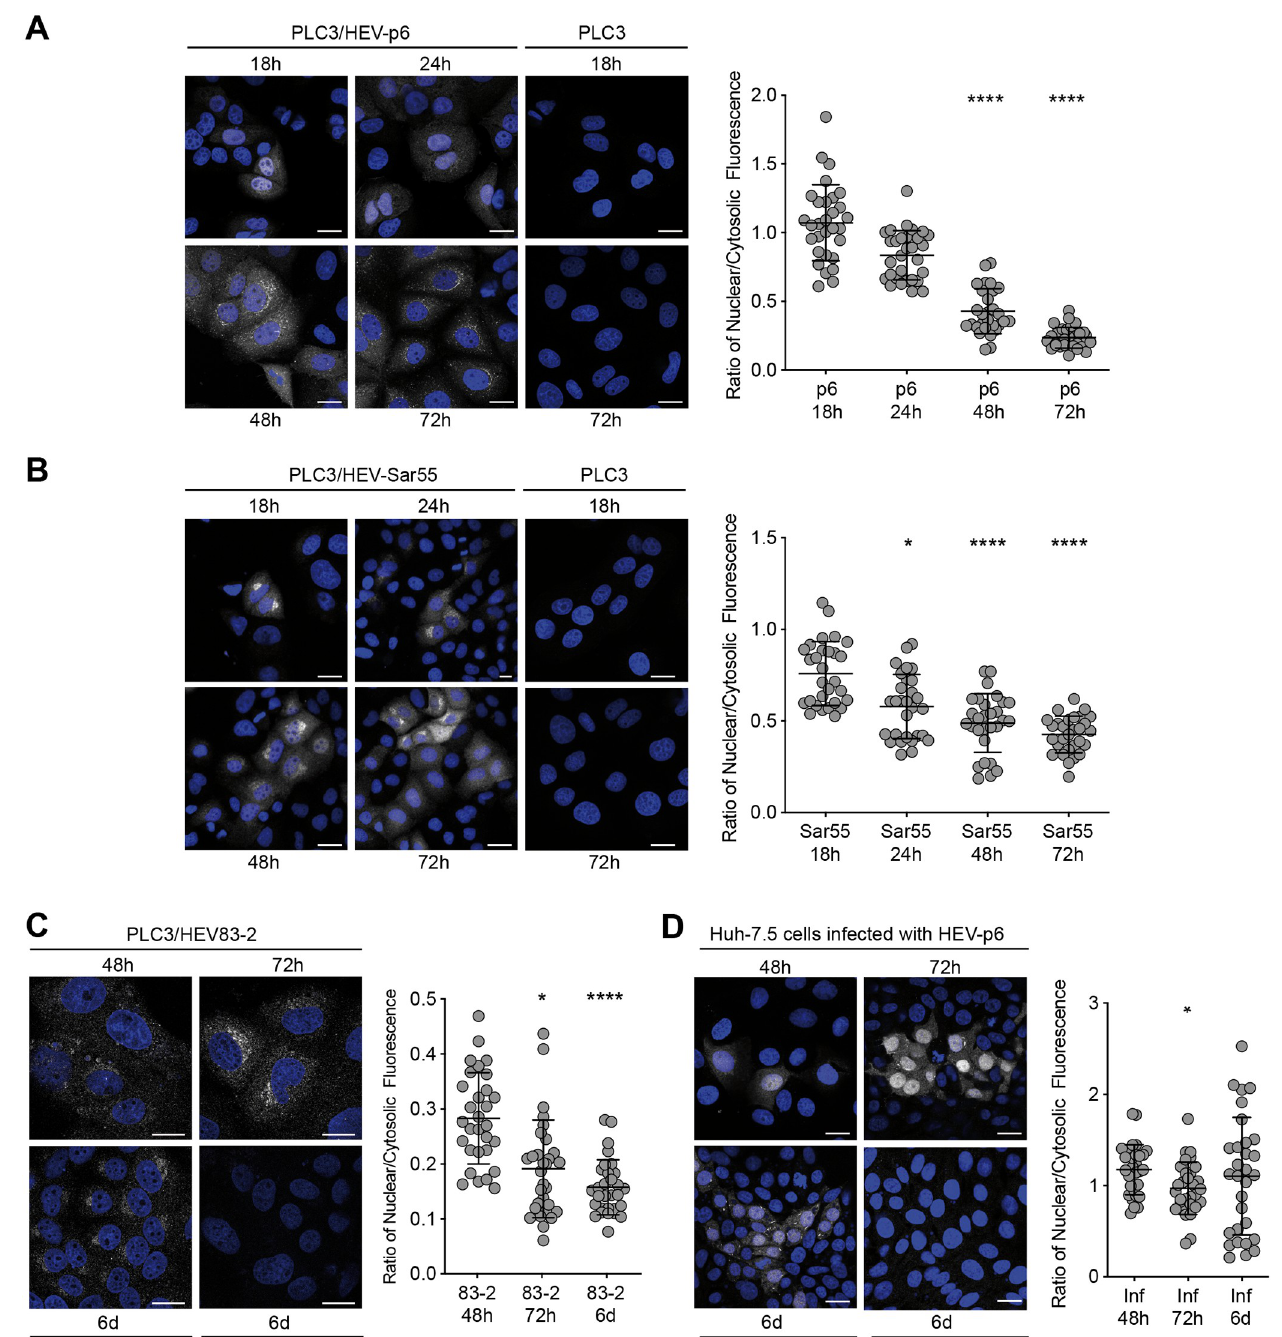
Fig 1. Kinetics of the subcellular localization of ORF2 protein. PLC3 cells electroporated with HEV-p6 (A), HEV-Sar55 (B) and HEV83-2 (C) RNA and Huh-7.5 cells infected with HEV-p6 (D) were fixed at the indicated timepoints post-electroporation (p.e.) (A-C) or post-infection (p.i.) (D). Indirect immunofluorescence analysis was performed using the 1E6 anti-ORF2 antibody. Cells were analyzed by confocal microscopy (magnification x40). Scale bar, 20 μ m. Nuclear/cytosolic fluorescence intensity quantification was done using ImageJ software (mean ± S.D., n � 30 cells, Friedman with Nemenyi test). � p < 0.05, ���� p < 0.0001. Mock electroporated PLC3 cells (PLC3), cells electroporated with a replication-deficient HEV83-2 strain (PLC3/HEV83-2-GAD) and non-infected Huh-7.5 cells were used as controls.